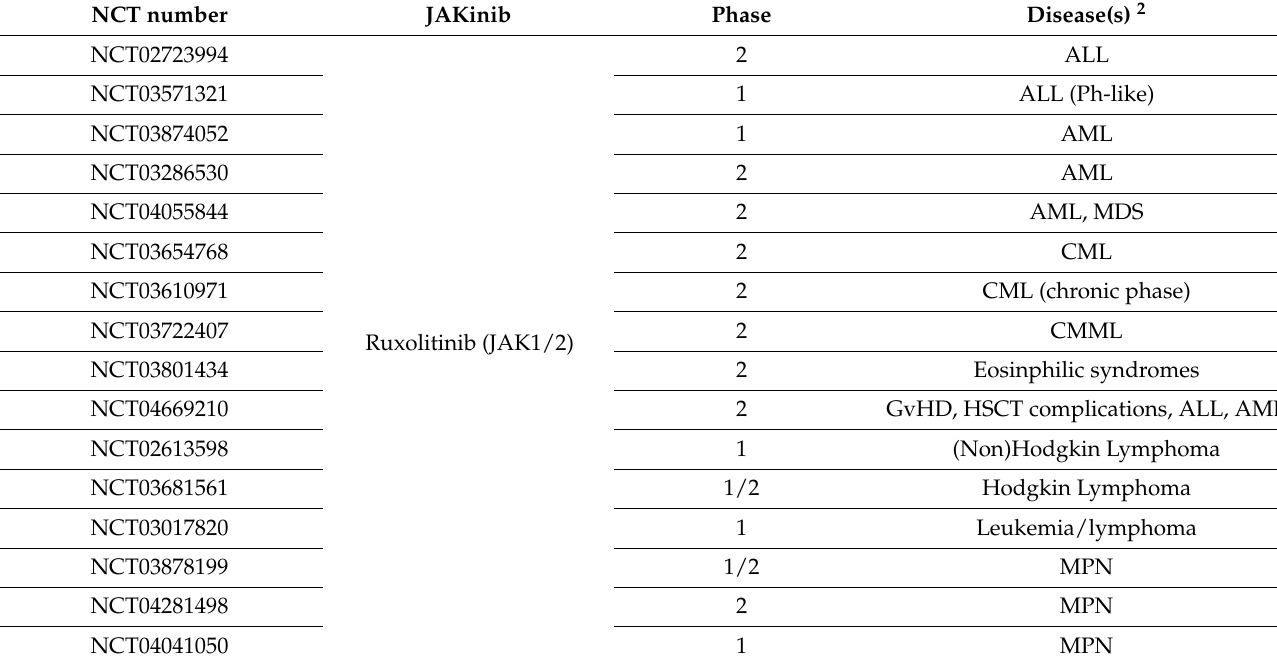
Table 2. Ongoing clinical trials for JAKinibs in hematological malignancies (as for April